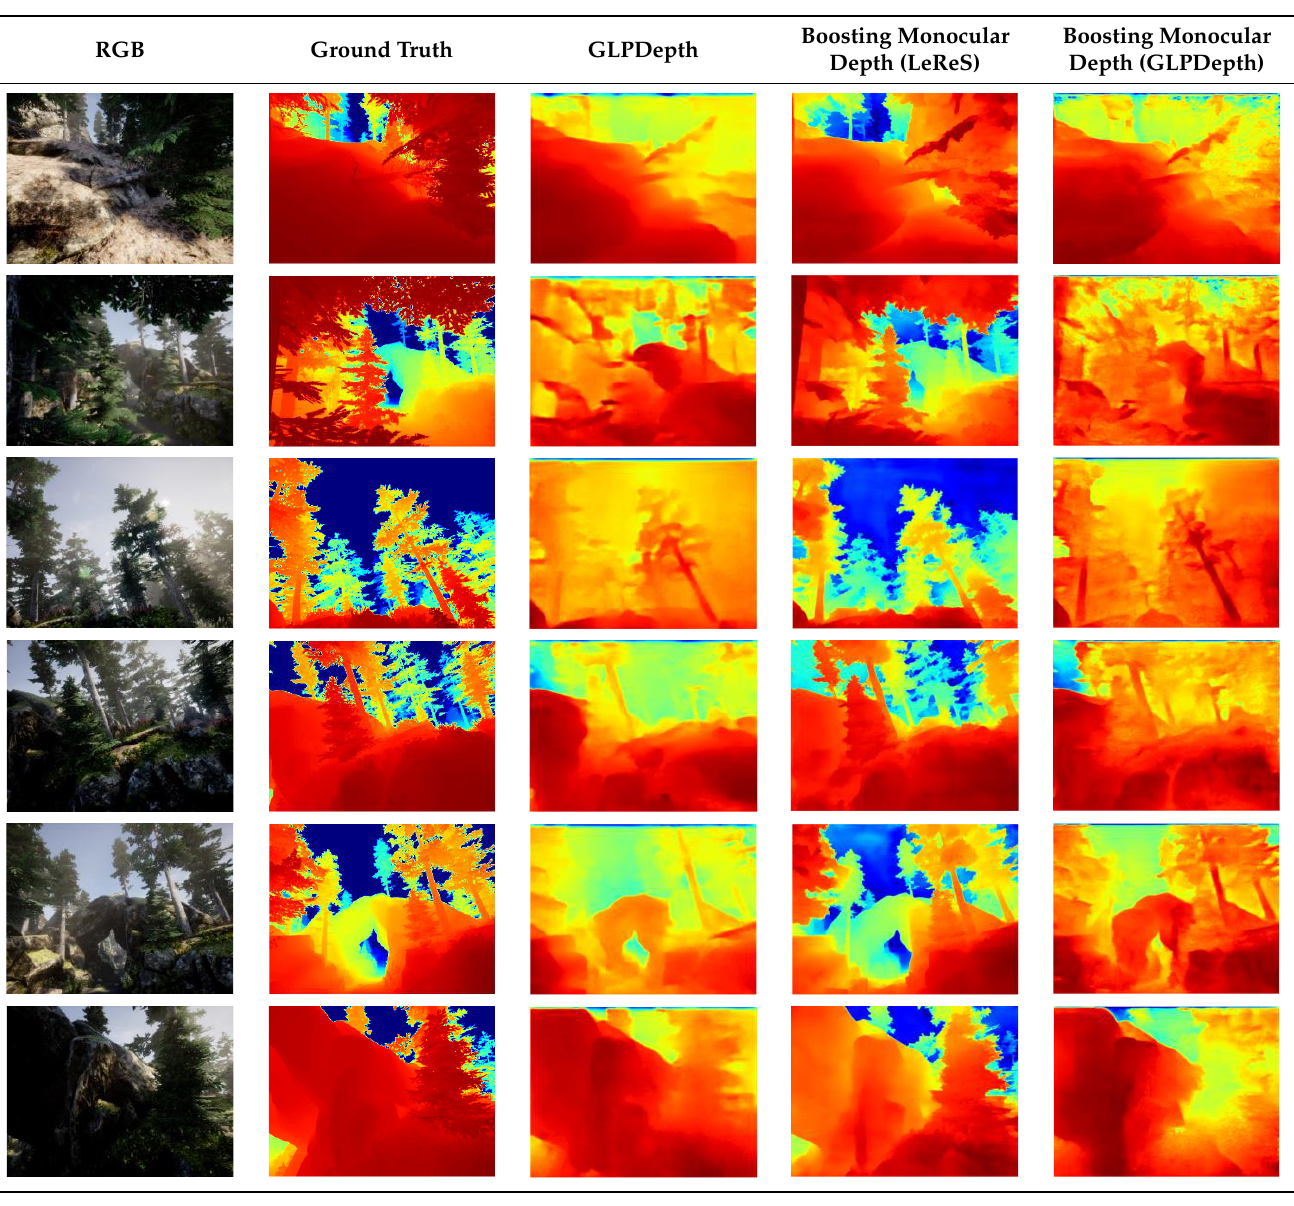
Table 8. Comparison of depth maps generated by GLPDepth, Boosting Monocular Depth (LeReS), and Boosting Monocular Depth (GLPDepth).